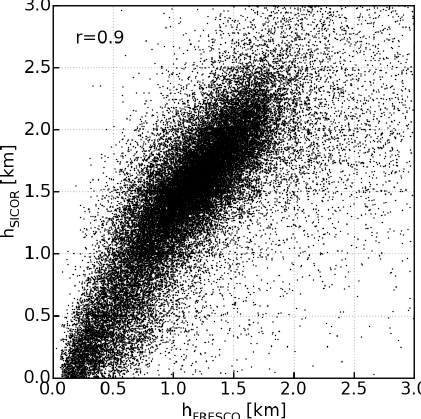
Figure 1. Scatter plot of the retrieved cloud height h SICOR in kilo- metres against that provided by Fresco h FRESCO . Data are shown for the year 2003 over the ocean in the latitude/longitude box [(30 ◦ S, 30 ◦ W), (0 ◦ ,0 ◦ )] with cloud optical thickness > 1.